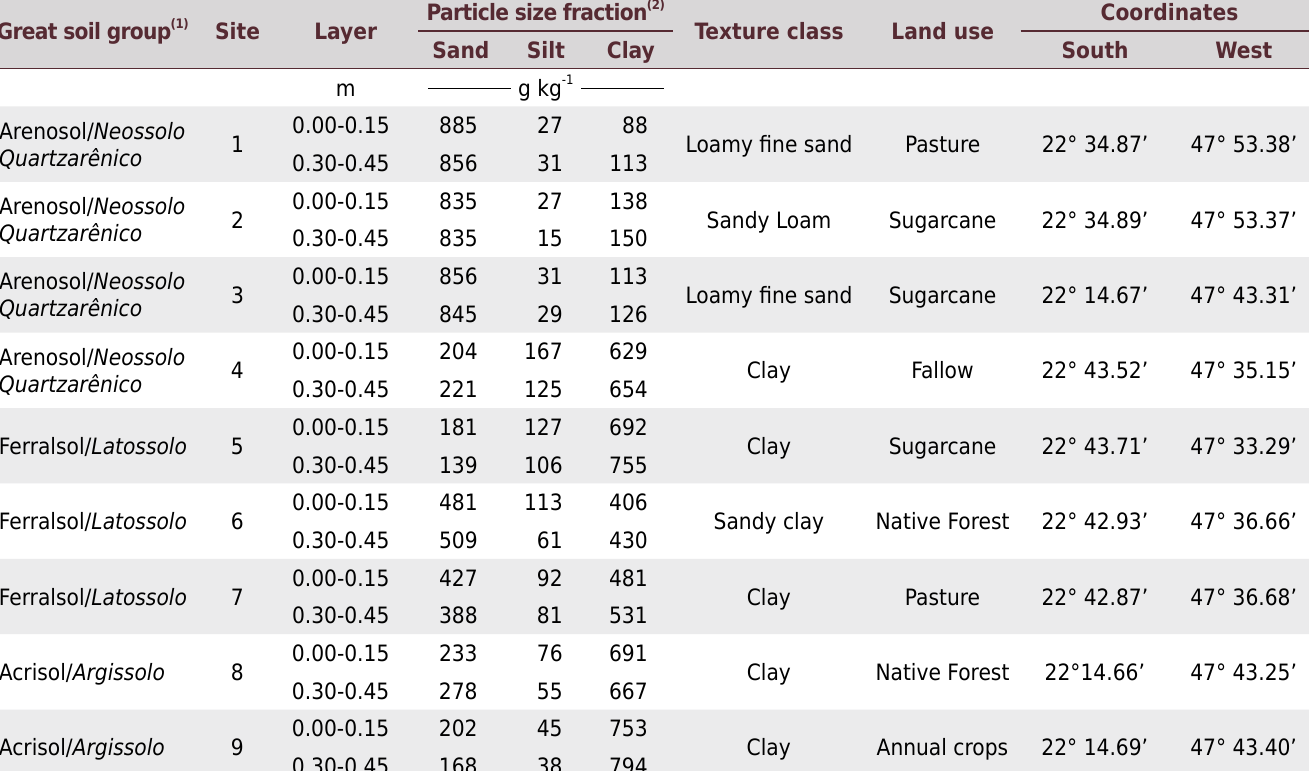
Table 1. Particle size distribution, soil texture class, and current land use at the 9 sampling